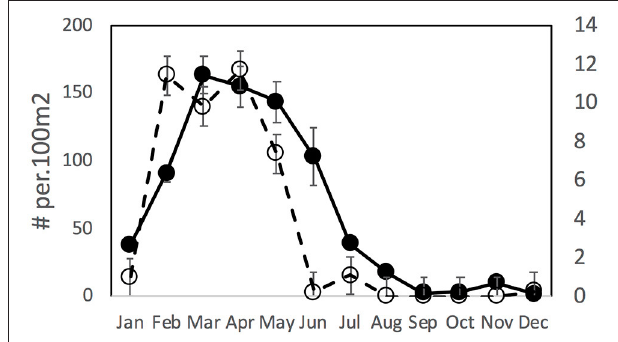
FIGURE 2 | Mean ( ± SE) density of tropical vagrant fishes overall in Sydney (solid line, solid symbol curve, left Y axis) and Merimbula (dashed line, open symbol, right Y axis) over 12 months, n = 14 years.